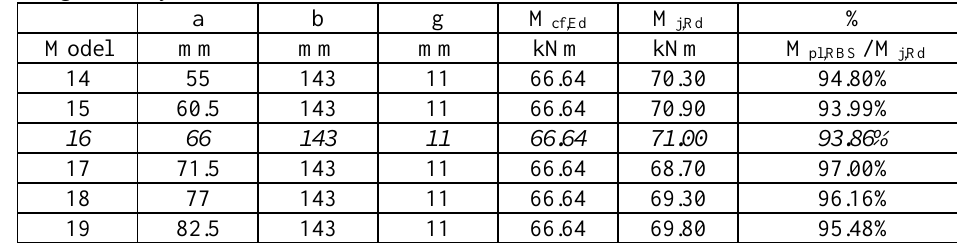
Results of stage 3 analysis.